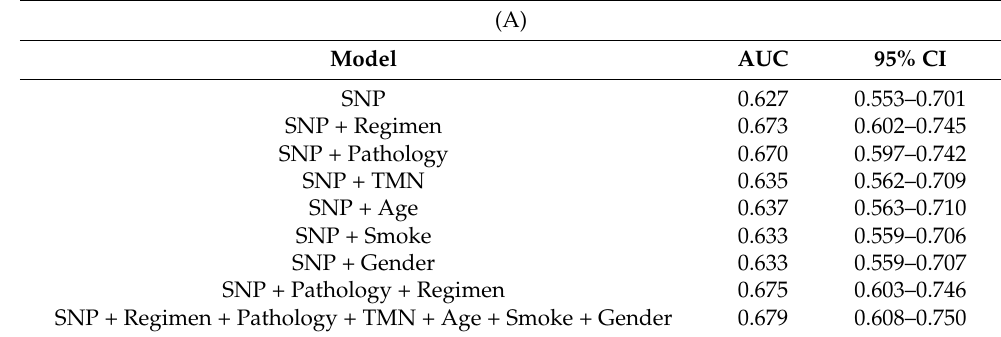
Table 4. (A) The AUCs of models established by SNPs combined with different clinical factors in the discovery cohort. (B) The AUCs of models established by SNPs combined with different clinical factors in the discovery cohort of adenocarcinoma samples. (C) The AUCs of models established by SNPs combined with different clinical factors in the discovery cohort of squamous carcinoma